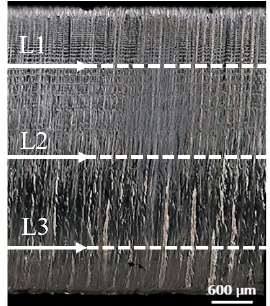
8 of 23 Figure 3. Schematic of kerf geometry. To highlight the dependence of geometrical response variables on the position at which their measurement was taken, the position was included in the statistical analysis as a control factor. It is useful to point out that it would be more correct to consider the position as a covariate, but the ability to discriminate between response measurements representing different levels of position would be lost. Furthermore, assuming the position as a control factor, it is possible to verify the effect of its interaction with the other control factors on the variables of interest. The geometrical response variables were measured using a 3D digital video microscopy system (Hirox KH-8700) equipped with MXG-2500 ‘revolver’ optics. 3D images of kerf sections were produced by continuously stacking the depth of field in the vertical axis, focus point to focus point, and simultaneously scanning the surface in the horizontal axis. The roughness of the side cut surface is a typical issue of laser beam cutting and a critical factor for laser cut quality. The formation of a drag line arises from irregularity in the laser beam process such as small drifts or disturbances, solidification of melted material and curvature of the cut front. The cut surface roughness was measured in terms of arithmetic mean surface roughness (Ra), surface roughness depth (Rz) and mean width of profile elements (RSm) perpendicular to the cutting direction, on an evaluation length of 20 mm with a spacing of 2 µm (in accordance with ISO 4287:1997). The roughness profiles were measured using an inductive profilometer (Taylor Hobson Talysurf CLI 2000) equipped with a spherical diamond tip (2 µm radius) and processed by means of a surface analysis software (Talymap Universal 3.1.4). Since, as known, surface roughness is generally